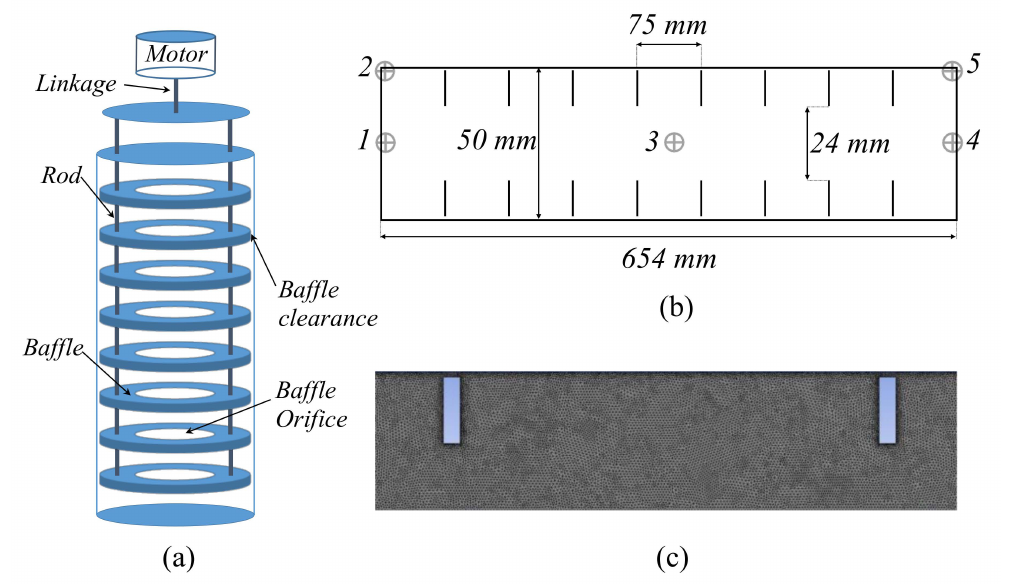
Figure 1. ( a ) Schematic of the moving ba ffl e oscillatory ba ffl ed reactor (OBR) [25], ( b ) modified geometry used for modeling (Points 1 to 5 are used for measuring the mixing time, which will be explained in Section 3.2), and ( c ) image of the mesh created (one cell (inter-ba ffl e zone) is